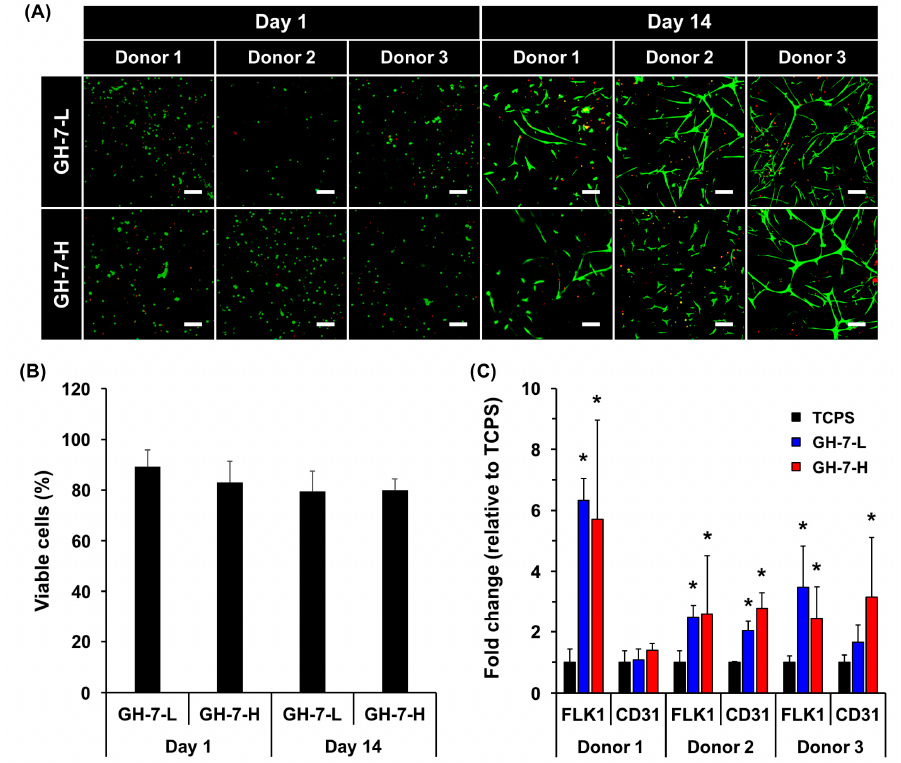
Figure 3. In vitro endothelial differentiation of patient-derived MSCs cultured in GH hydrogels. Live/dead staining images of hMSCs in GH-7-L and GH-7-H gels on days 1 and 14 post culture. Scale bars = 100 µm ( A ); Quantification of viable cells (%) at day 1 and 14 ( B ); mRNA expression levels of endothelial cell markers (FLK1 and CD31) in hMSCs determined by qRT-PCR after 21 days of culture in GH gels. As a control, the same number of cells was seed on TCPS. * p < 0.05 vs. TCPS ( n = 3) ( C ).